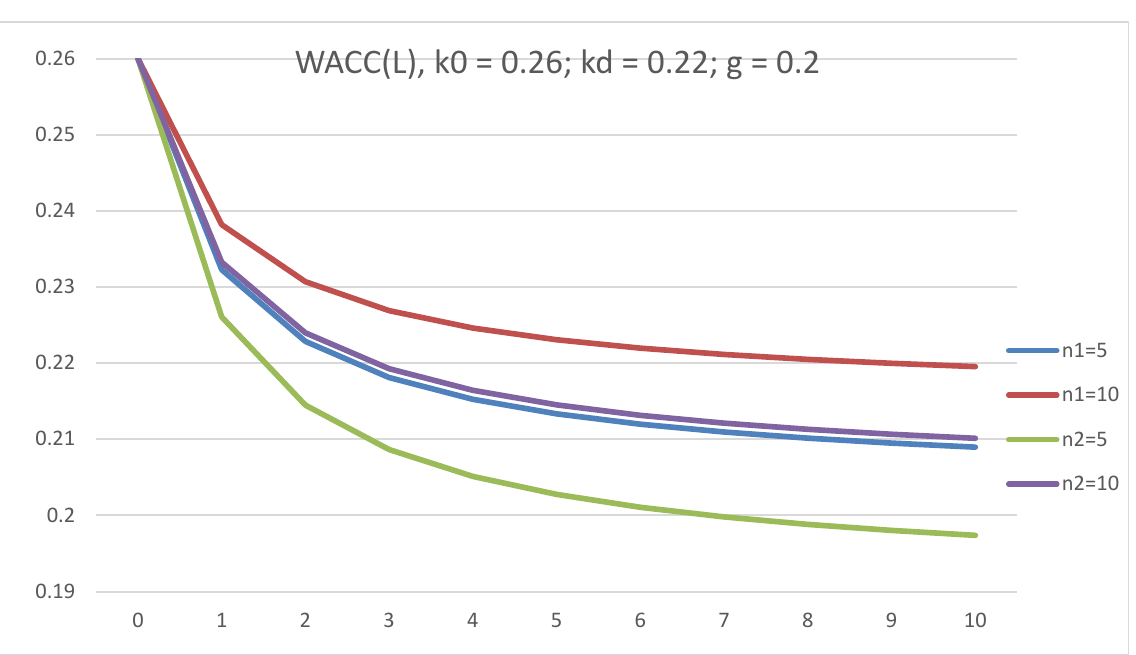
Figure 9. The dependence of WACC on leverage level, L, in GBFO theory with payments of tax on profit at the end of periods (1) and advance payments (2) at k 0 = 0.26; k d = 0.22; t = 0.2; g = 0.2, for five-year and ten-year companies.